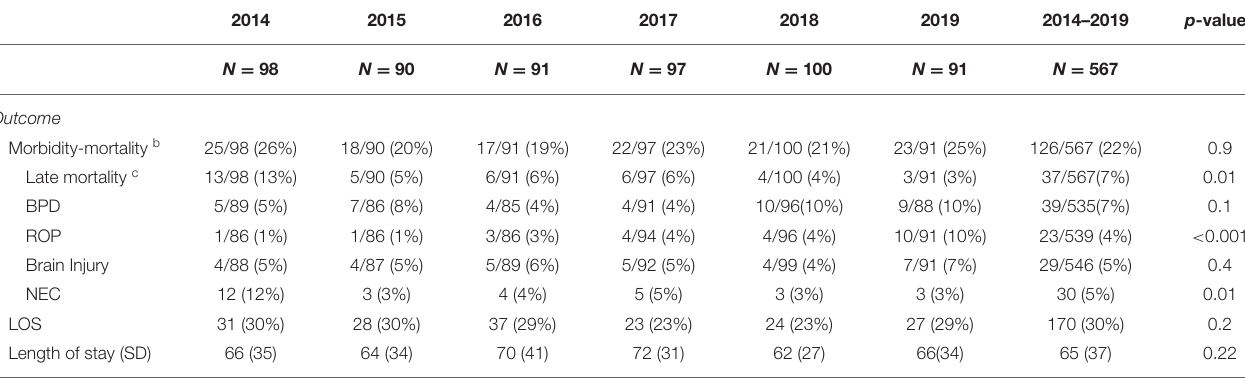
TABLE 2 | Evolution of morbidity and mortality, LOS, and hospital stay between